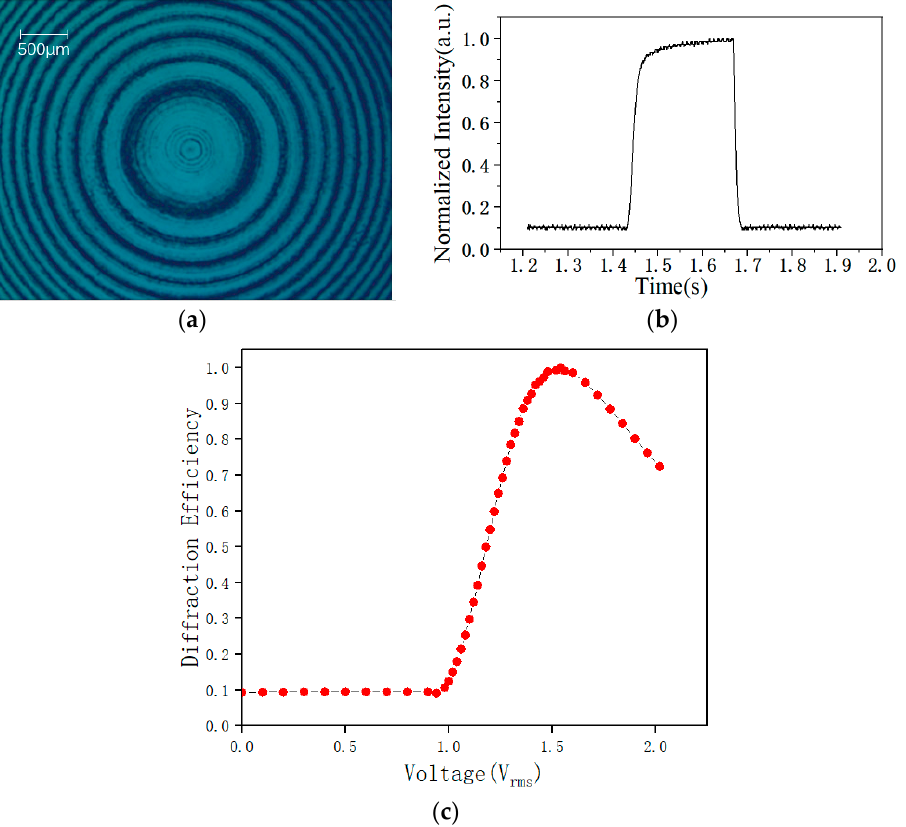
Figure 6. GP lens ( a ) optical micrograph under crossed polarizers; ( b ) response time; and ( c ) voltage-dependent first-order di ff raction e ffi